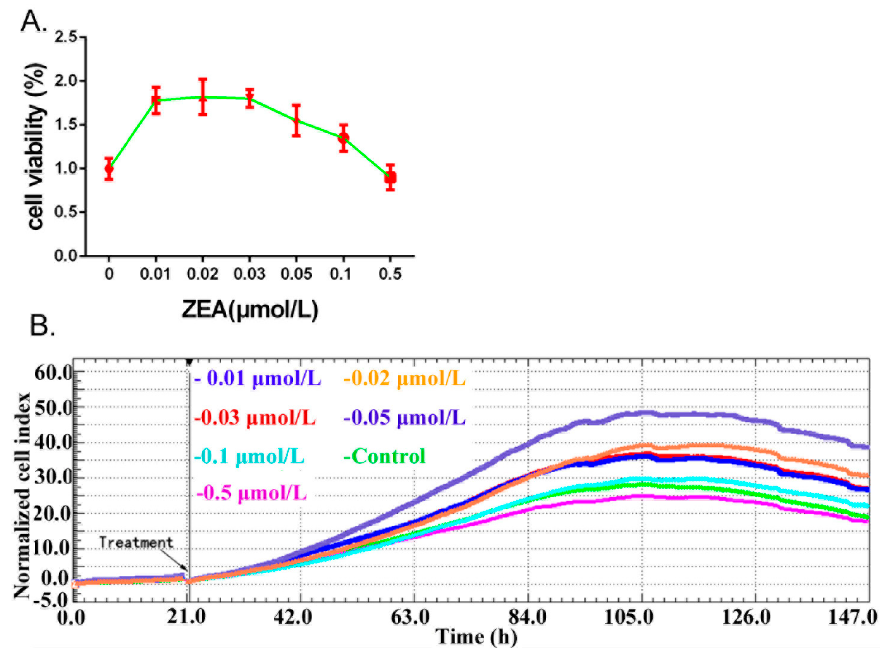
Figure 1. The effects of ZEA on the cell proliferation in TM3 cells. ( A ) Cell viability was detected